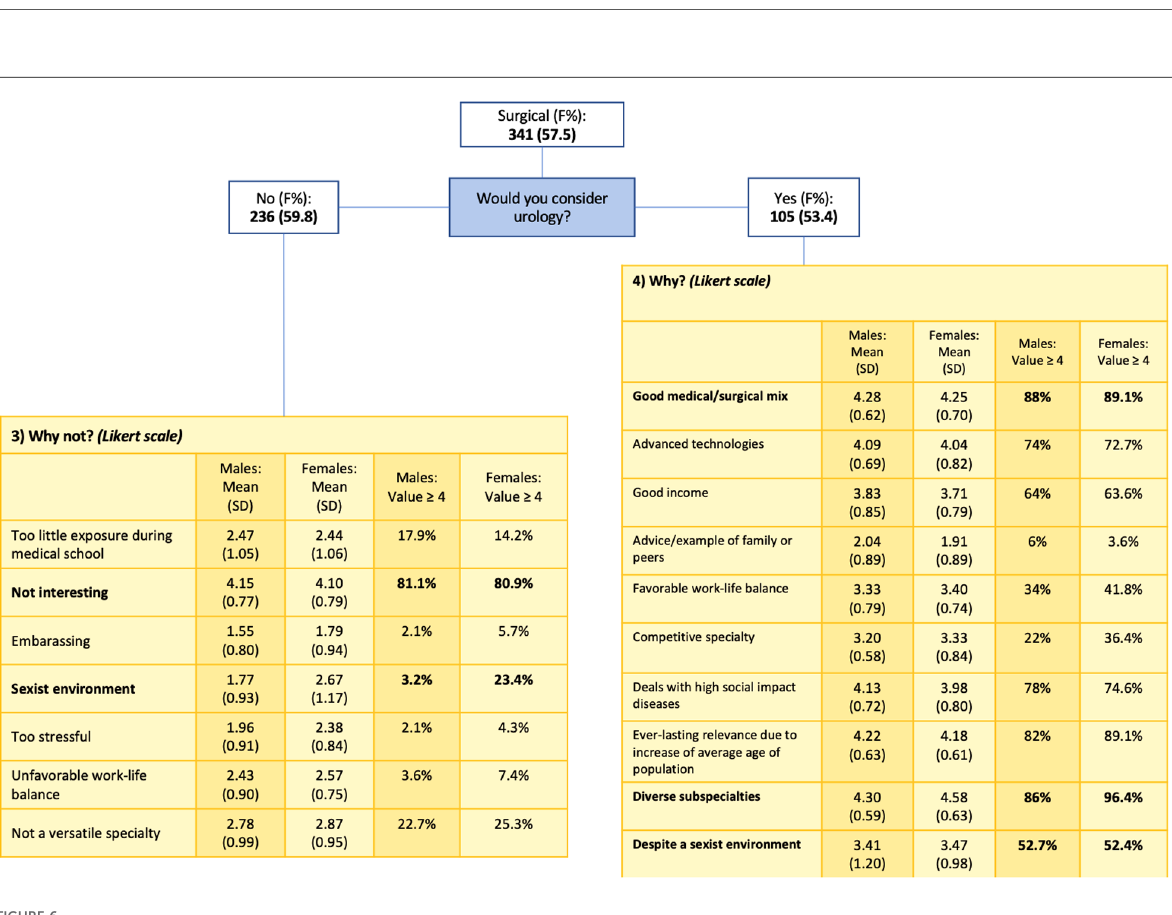
FIGURE 6 Reasons for not choosing vs. choosing Urology, with male and female respondents expressed as mean, standard deviation (SD), and values ≥